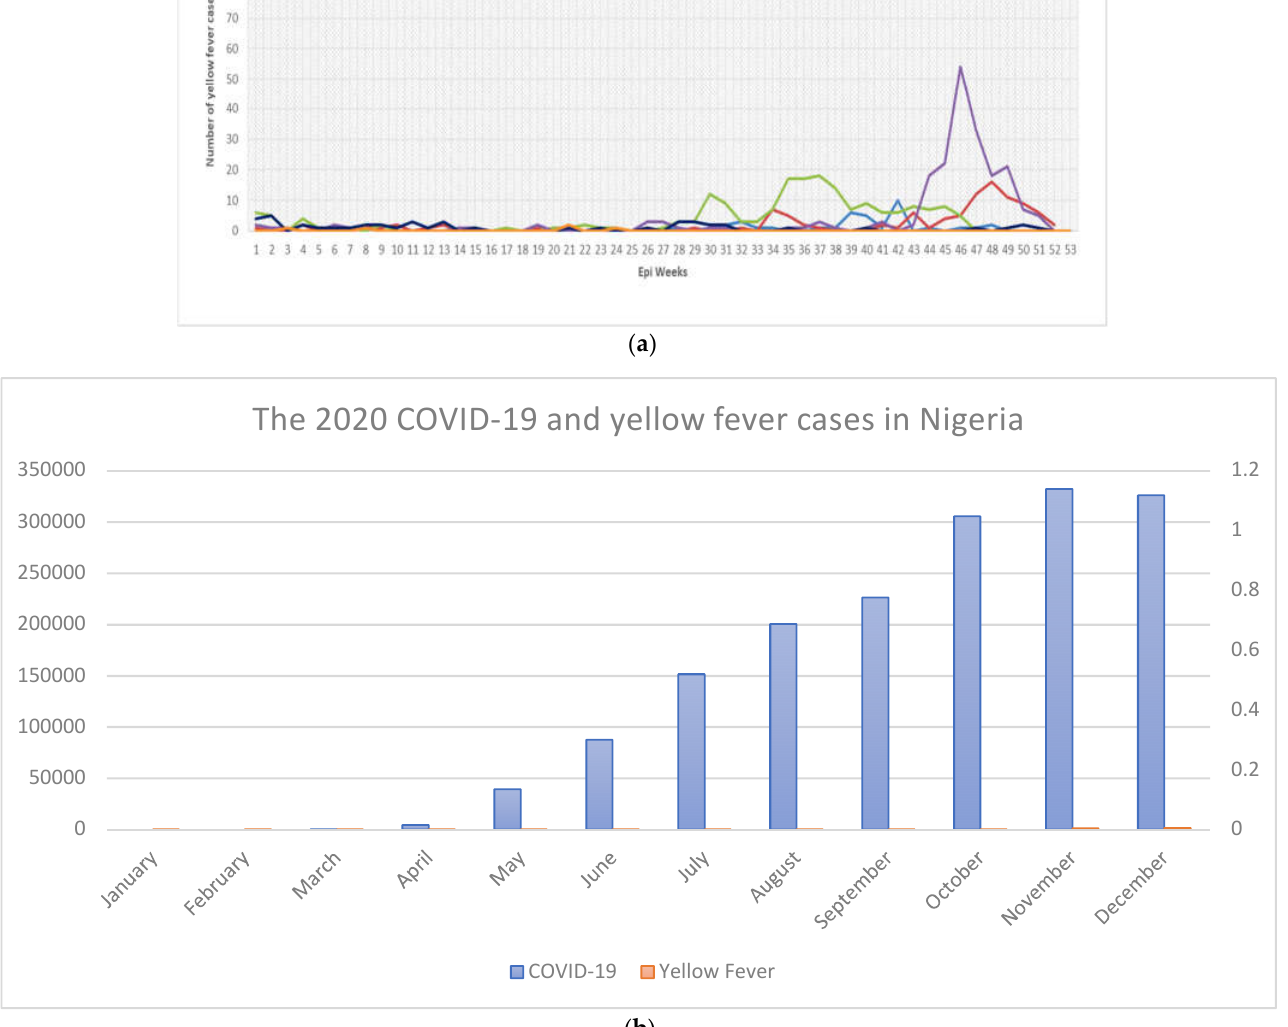
Figure 2. ( a ): Comparing epidemiological spread of yellow fever in 2017–2022. The 2020 had the highest number of confirmed cases of YF than any other years in Nigeria. The common season for most reported cases of YF is the months of September through December. In 2021, there were few cases of YF as most people became vaccinated, and due to continuous implementation of COVID-19 prevention protocols. However, as COVID-19 restrictions become completely phased out, and hospitals across Nigeria began to see rises in COVID-19 new cases, infections with YF begins to rise higher than pre-COVID-19 years, as seen in Figure 2. This further suggests a possible correlation between SARS-CoV-2 and yellow fever co-infection. ( b ) Shows consistent rise in COVID-19 infection with a concurrent rise in yellow fever infection, even though not visible on the chart base on the higher number of COVID-19 cases compared to yellow fever